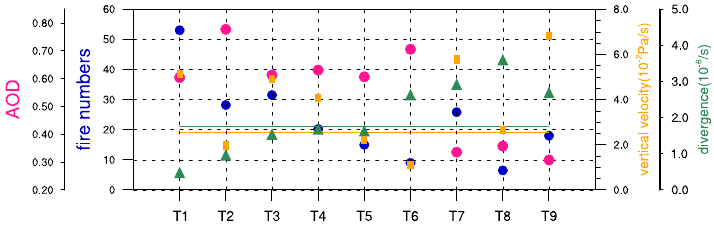
Figure 18. The values of AOD (peach), number of fires (blue), vertical velocity (orange) and divergence of low-level winds (green). The orange and green lines represent for the climatological average of vertical velocity and divergence respectively. T1–T9, namely Type 1– Type 9, mean the nine different types summarised in this